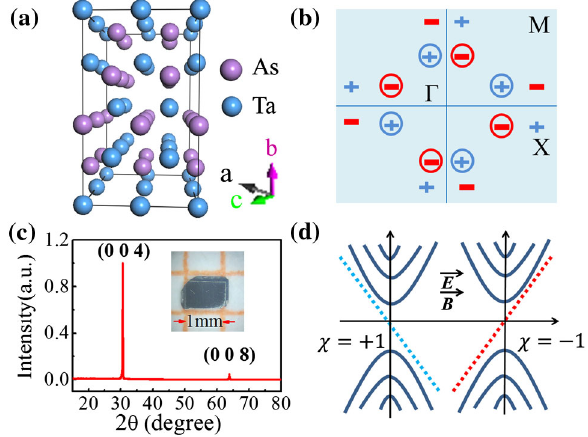
FIG. 1. Structure and symmetry of a TaAs single crystal. (a) The crystal structure of TaAs with a nonsymmorphic space group of I 4 1 md . Blue and violet balls represent a Ta atom and an As atom, respectively. (b) Schematic diagram of a dozen pairs of Weyl points projected on the (001) facet. “ þ ” and “ − ” denote Weyl points with positive and negative chiralities, respectively. The circles show that there are two Weyl points with the same chirality projected on the same point in the (001) facet. Γ , X, and M are the high symmetry points in the Brillouin zone. (c) X-ray diffraction pattern of a TaAs single crystal. The inset shows an optical image of a typical sample at the millimeter scale. (d) Schematic diagram of bulk Landau levels of a pair of Weyl nodes. The dotted lines represent the zeroth quantum Landau Level with “ þ ” (blue) and “ − ” (red) chiralities in a magnetic field parallel to the electric